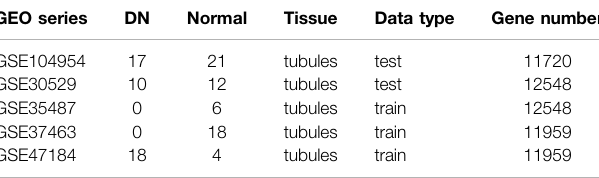
TABLE 1 | The information of GEO datasets in this